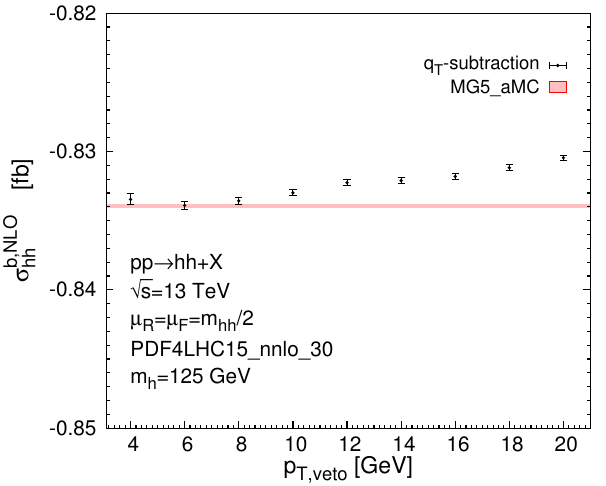
Figure 5 . The p veto dependence of the total NNLO cross section for the class- b at T LHC. The error bars denote the Monte Carlo integration uncertainties.